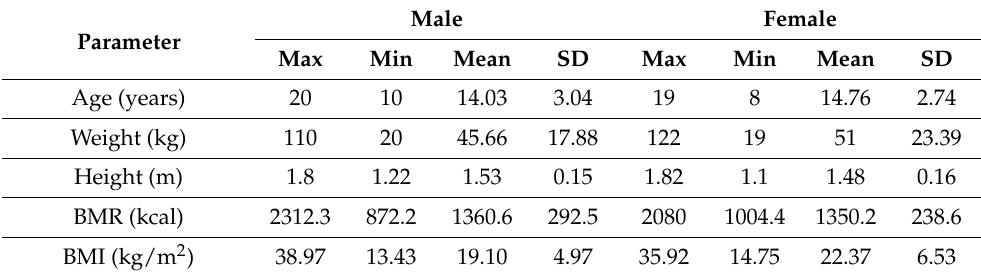
Table 4. Summary of the physiological parameters of patients.